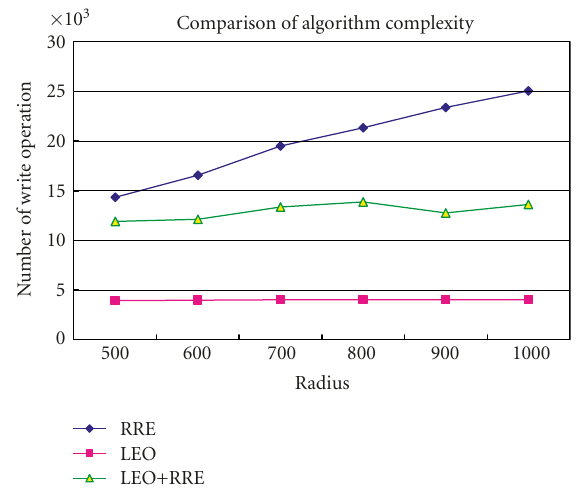
Figure 11: Comparison of number of write operations with network area 10000 × 10000, number of tags = 4000, and number of readers =